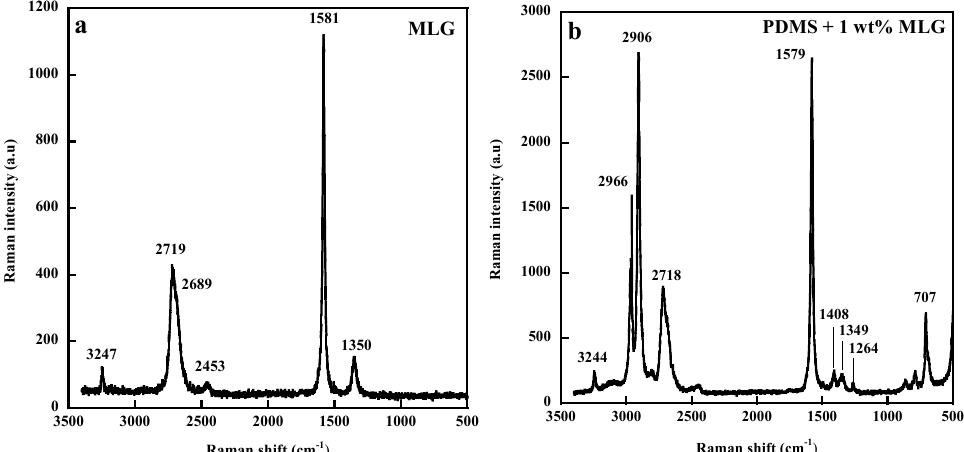
Figure 3. Raman spectra of multilayer graphene (MLG) ( a ) and of poly(dimethylsiloxane (PDMS) filled with 1 wt% of MLG ( b ) under excitation at 532 nm. Reproduced with permission from [63].